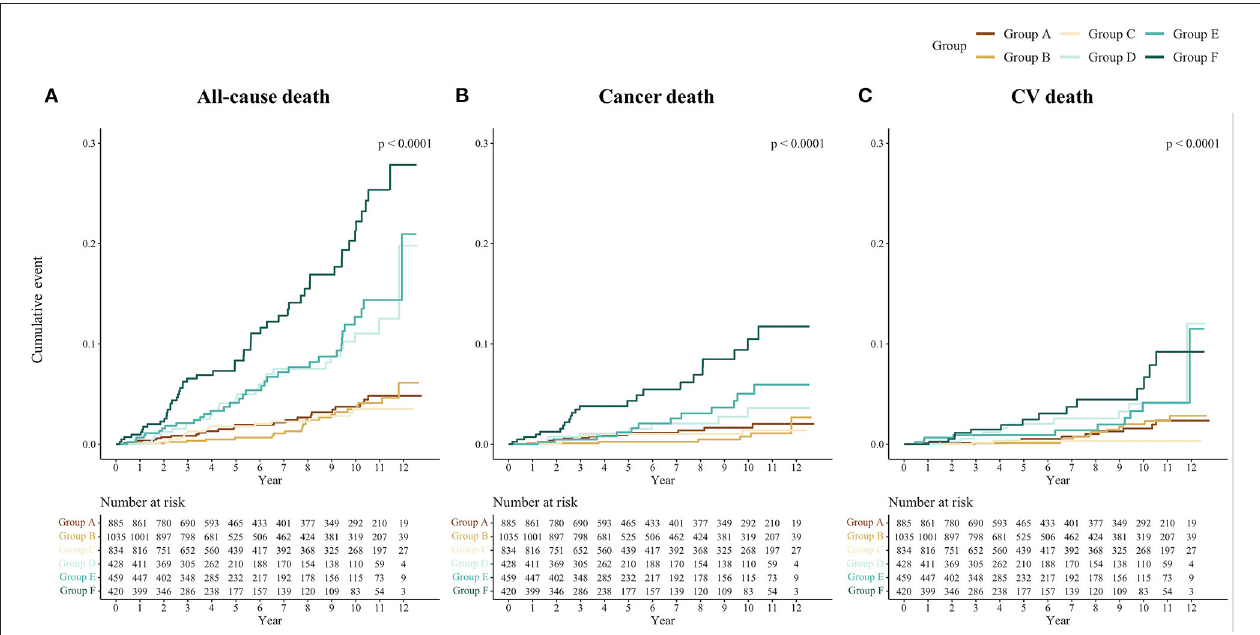
FIGURE 2 | Cumulative incidence by outcomes and the GDF-15/BMI-based groups. Kaplan-Meier curves of the cumulative incidence rates of (A) all-cause, (B) cancer, and (C) CV death by the GDF-15/BMI-based study group are shown. The GDF-15/BMI-based study groups were as follows: Group A, non-elevated GDF-15 ( < 1,200 ng/L) with normal BMI (22.5–25.0 kg/m 2 ); Group B, non-elevated GDF-15 with high BMI ( ≥ 25.0 kg/m 2 ); Group C, non-elevated GDF-15 with low BMI ( < 22.5 kg/m 2 ); Group D, elevated GDF-15 ( ≥ 1,200 ng/L) with normal BMI; Group E, elevated GDF-15 with high BMI; and Group F, elevated GDF-15 with low BMI. GDF-15, growth differentiation factor-15; BMI, body mass index; CV death, cardiovascular death.